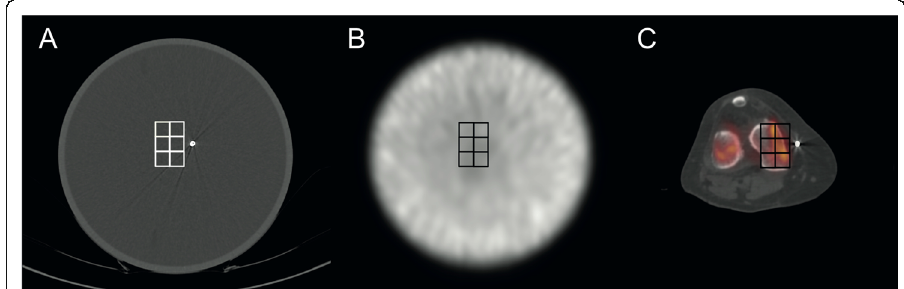
Fig. 4 Positioning of the standardized ROI set in the hybrid phantom (femur region) in correlation to the load absorber. a Positioning of the ROI set in the CT scan for analyzing the effect of the CT artifact from the joint-unloading prosthesis on HU values and b the corresponding attenuation corrected quantitative SPECT data. c Identic ROI setup transferred to a typical patient illustrating the correlation between the ROI set and the examined anatomic region (exemplified the femur region)